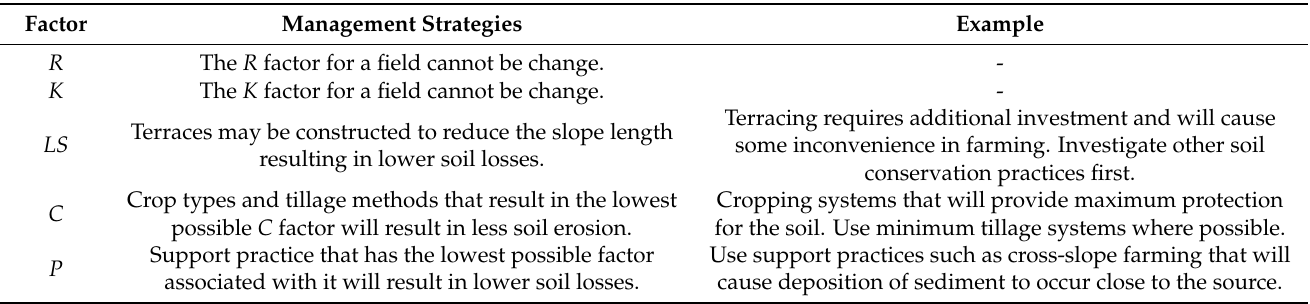
Table 3. Management strategies for reducing soil erosion.